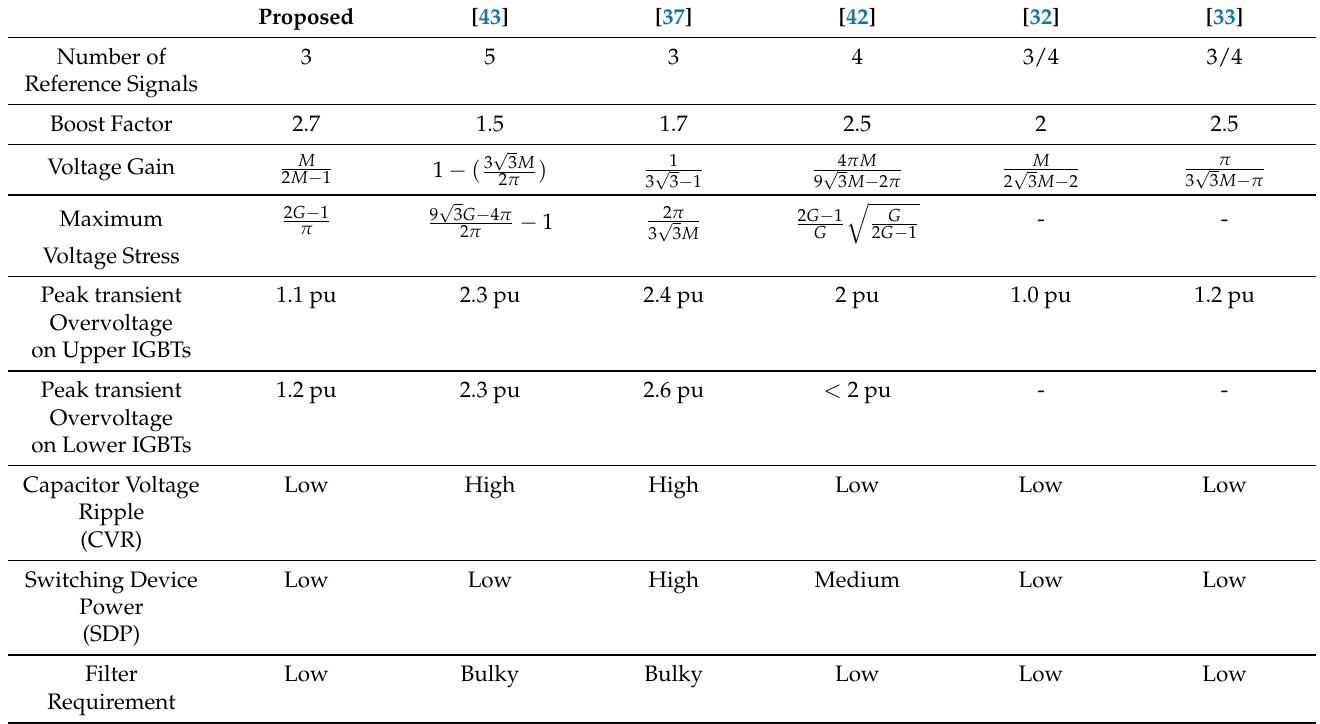
Table 1. Comparison parameters of Modulation